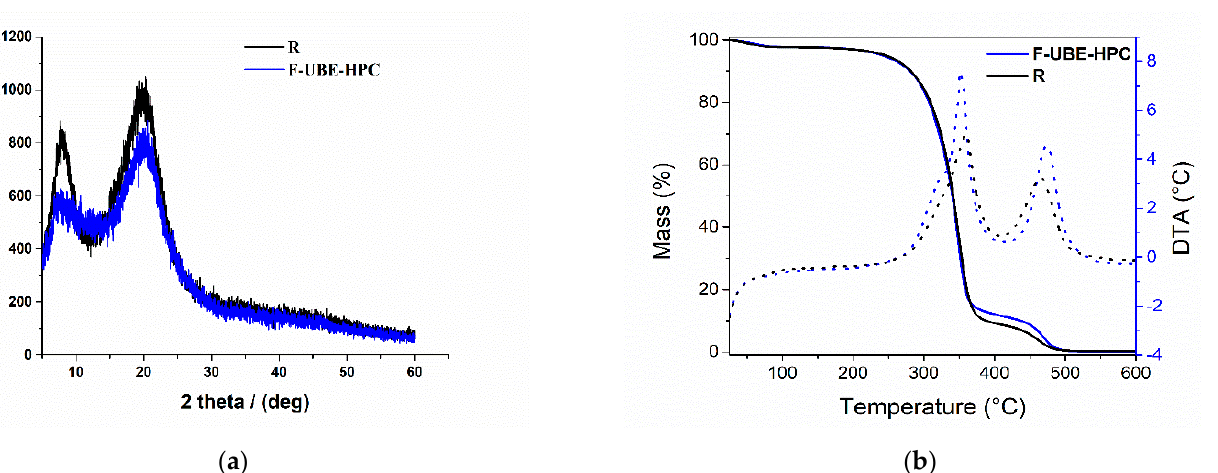
Figure 4. ( a ) XRD pattern and ( b ) TG/DTA curves of bioadhesive oral films: R (black line) and F-UBE-HPC (blue line). R—bioadhesive oral film without active lichen extract; F-UBE-HPC—bioadhesive oral film loaded with U. barbata dry ethanol extract.